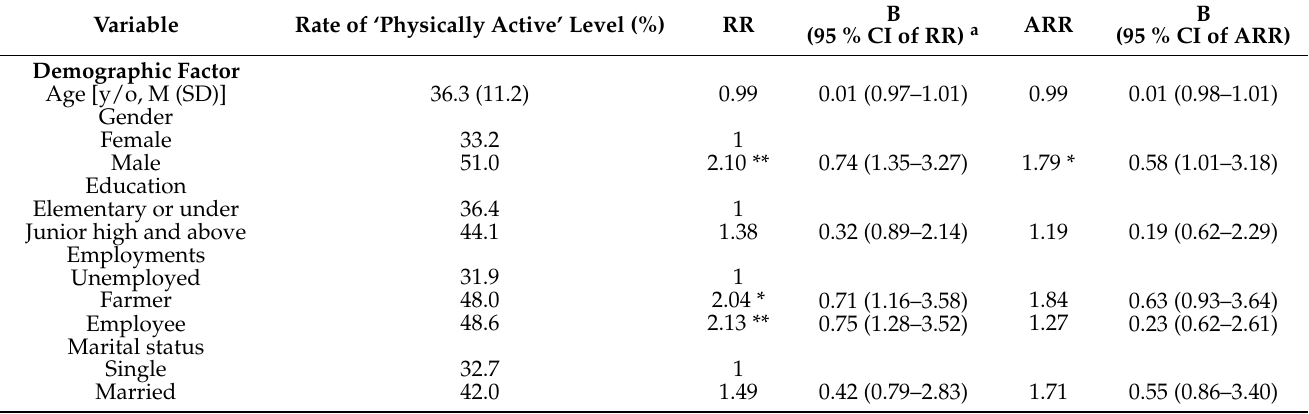
Table 3. The rate of ‘physically active’ levels, the rate of odds ratios (RR) from the bivariate analysis, and the adjusted RR (ARR) from the logistic regression were used to determine the factors for meeting the recommended physical activity level ( n =